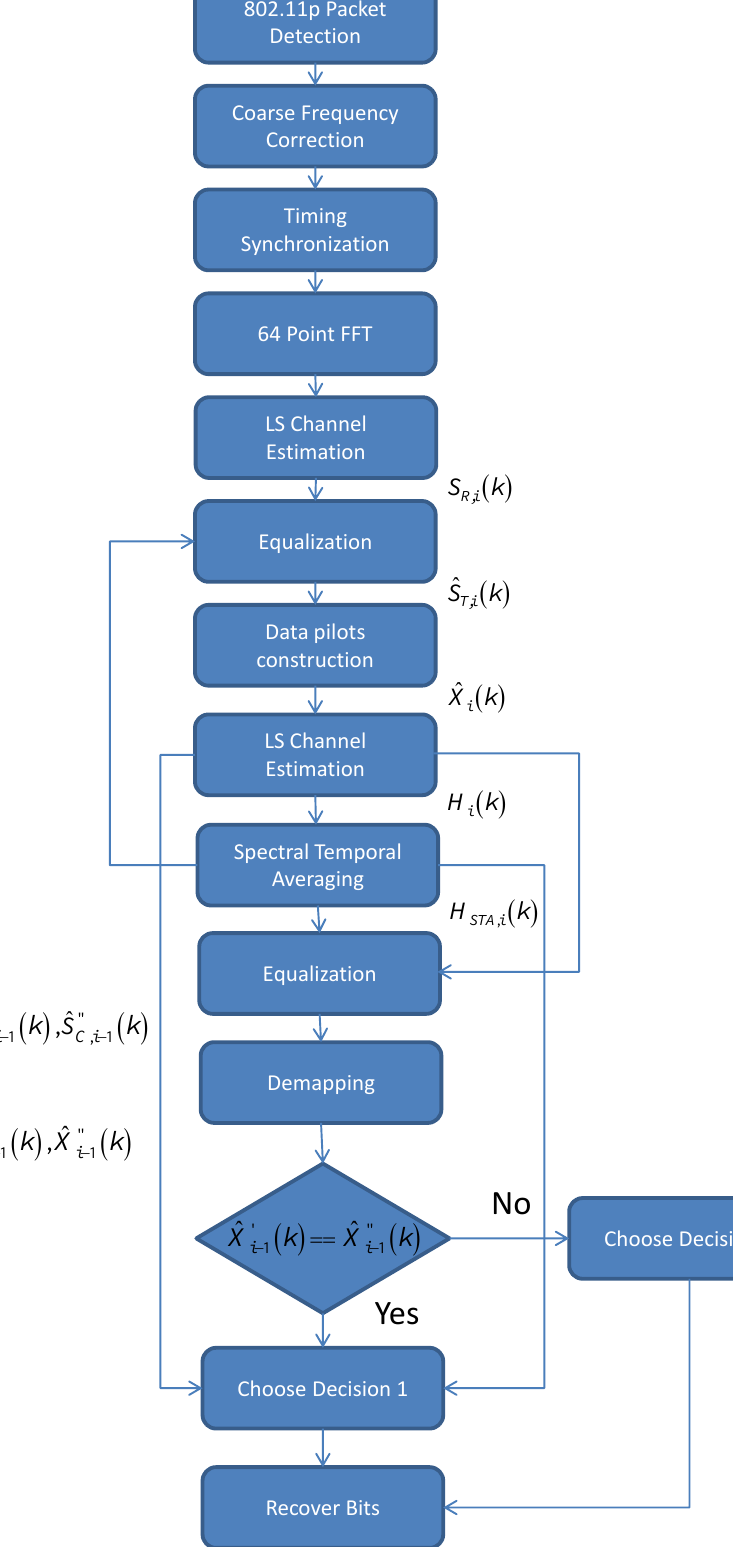
Figure 5. Process flow of the proposed